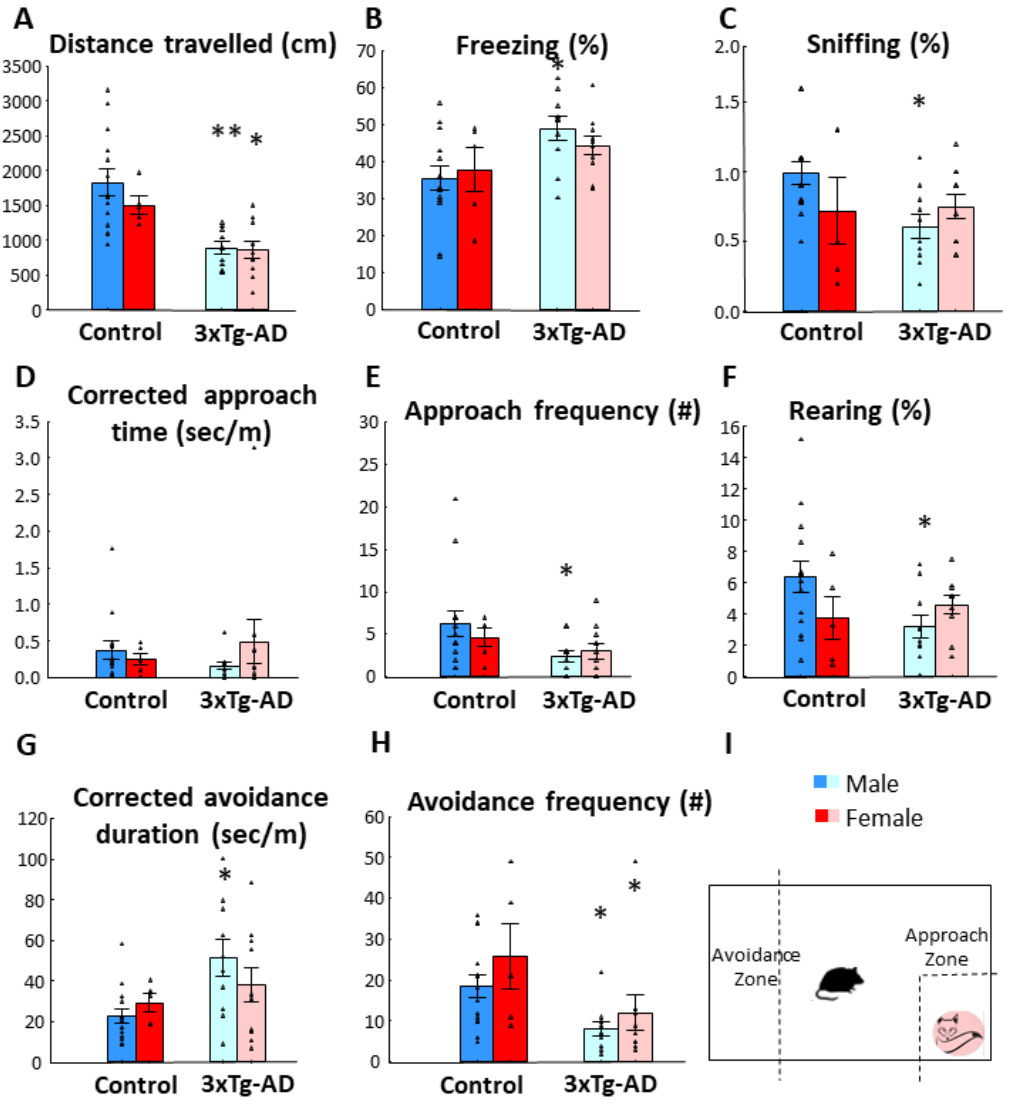
Figure 2. Fox odor avoidance behavior in 2-month-old male and female animals. (A ) Distance traveled in centimeters during 10 min. The 3xTg-AD moved significantly less than the controls ( p < 0.01) without sex difference. ( B ) Time spent freezing in percentage of 10 min observation period. The 3xTg-AD animals displayed increased freezing time ( p < 0.01). ( C ) Time spent sniffing on the fox odor container. No statistical significance was observed in genotype or sex. ( D ) Corrected approach time to fox odor zone. No statistical significance was observed in genotype or sex. ( E ) Frequency in which the animals approached the odor zone. The 3xTg-AD group displayed lower frequency than the control group ( p < 0.05). ( F ) Time spent rearing in percentage of 10 min observation period. No statistical significance was observed in genotype or sex. ( G ) Corrected avoidance duration. The 3xTg-AD animals spent more time in the avoidance zone than their age matched controls ( p < 0.01). ( H ) Number of entries into the avoidance zone. As 3xTg-AD animals spent more time in the avoidance zone, they entered less often ( p < 0.01). No main sex effect or genotype x sex interaction were observed in any of the presented parameters. ( I ) Schematic representation of the fox odor test. Data are shown as the mean ± SEM. The individual raw data points are represented as triangles. * p < 0.05, ** p < 0.01 vs. Control. # = amount of approach and/or avoidance